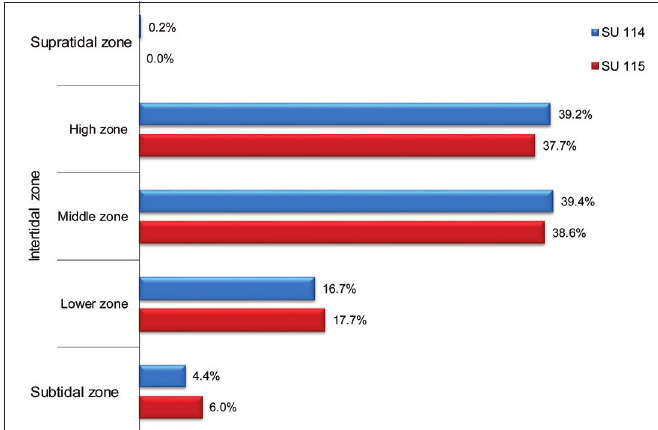
Figure 4: Collection areas in units 114 and 115 regarding littoral zonation: supratidal, inter- tidal (high, middle, low) and infratidal.